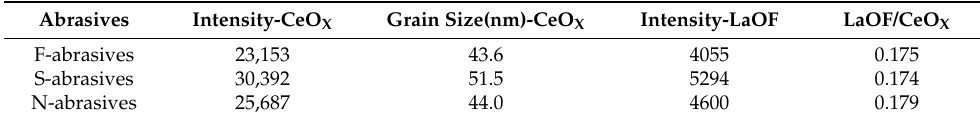
Figure 5. XRD diffraction patterns of ceria-based abrasives. Table 1. XRD phase information about LaOF and CeO X of ceria-based abrasives .